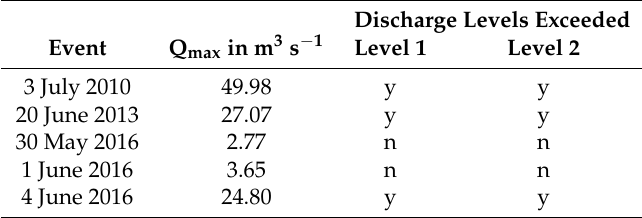
Figure 2. Study area. DWD radar locations by [59], overview elevation model by [67]. Table 1. Events examined for the Mehlemer Bach